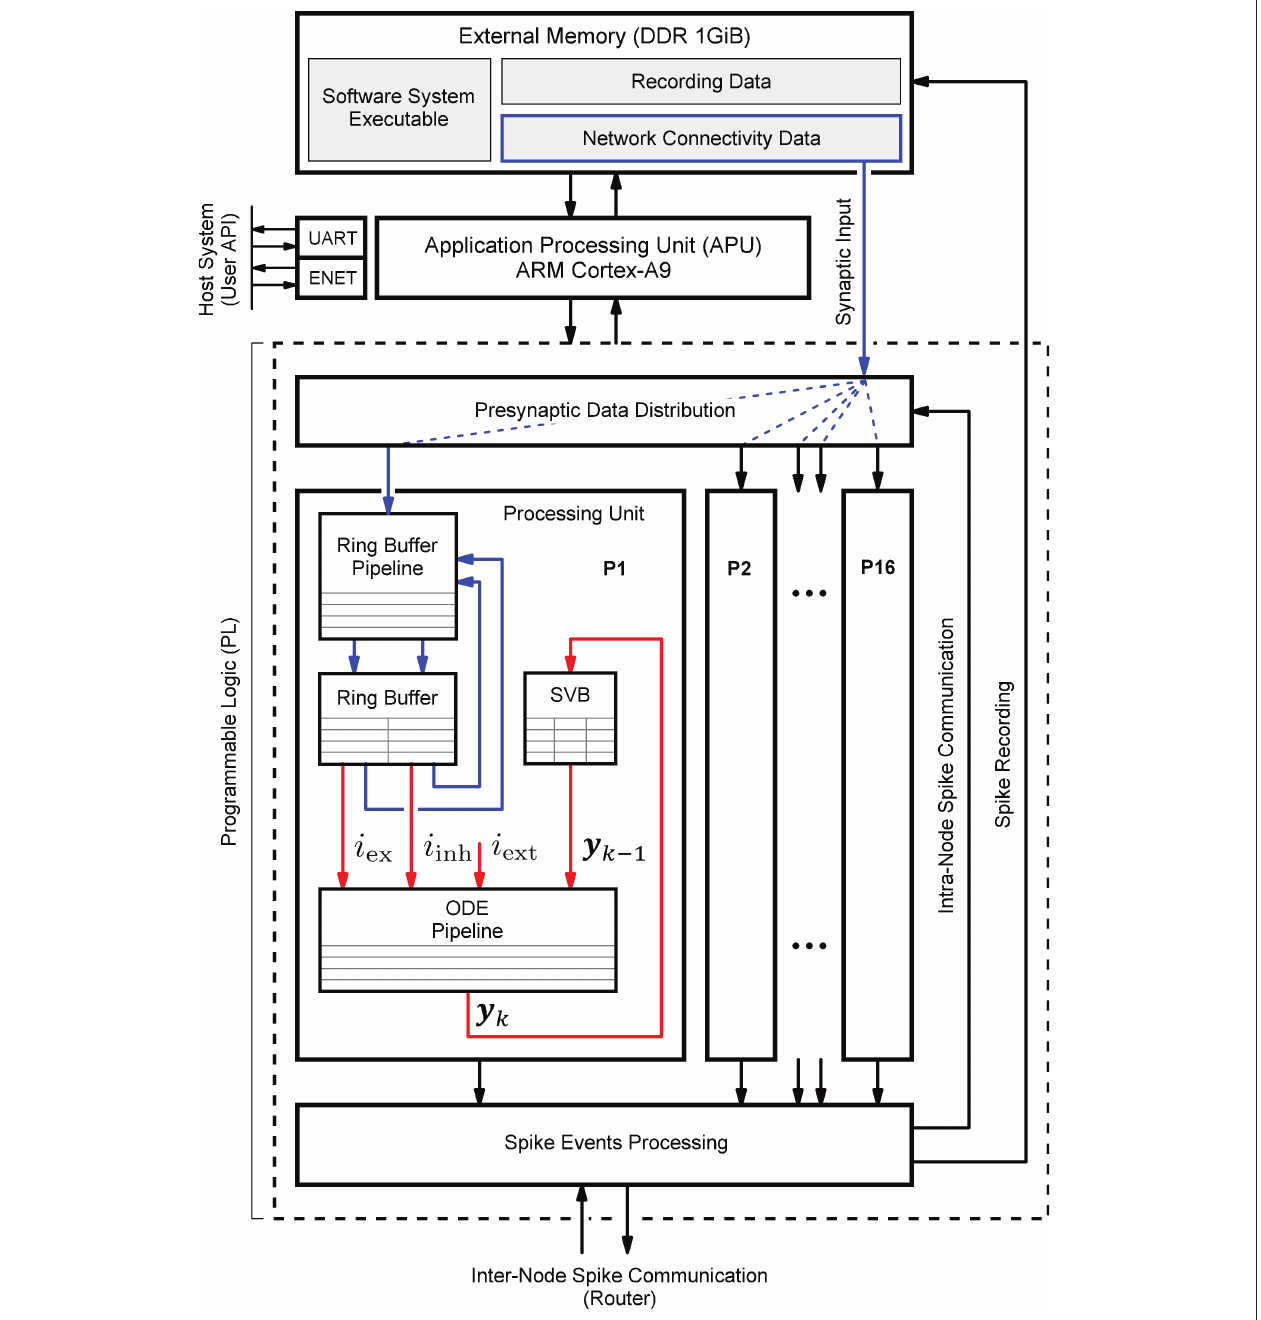
FIGURE 1 | Hybrid neuromorphic compute (HNC) node high-level architecture. The highest architectural level of the HNC node comprises three main components: an off-chip external memory (top), an application processing unit (APU; middle), and a programmable logic part (PL; lower dashed box). In order to distribute the workload and parallelize operations, the PL implements 16 identical processing units (P1, P2,.., P16). The red and blue arrows indicate two distinct processes that are critical to performance and primarily determine the performance characteristics and achievable acceleration factors. Red arrows: the process of the neuron and synapse model state update performed by the ordinary differential equations solver pipelines (ODE pipelines) which operate on fast on-chip block RAM memories that constitute the state variables buffer (SVBs). Blue arrows: the process of the presynaptic data distribution and processing which hold the data it operates on in the slow external off-chip